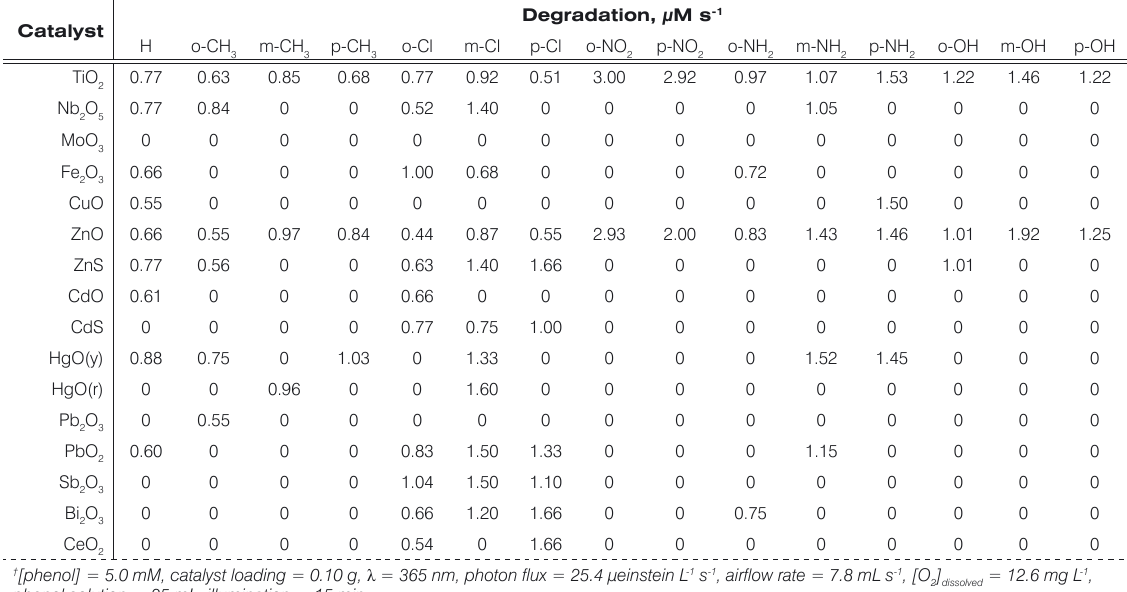
Table 1. Selective photocatalysis of phenol degradation by semiconductors †